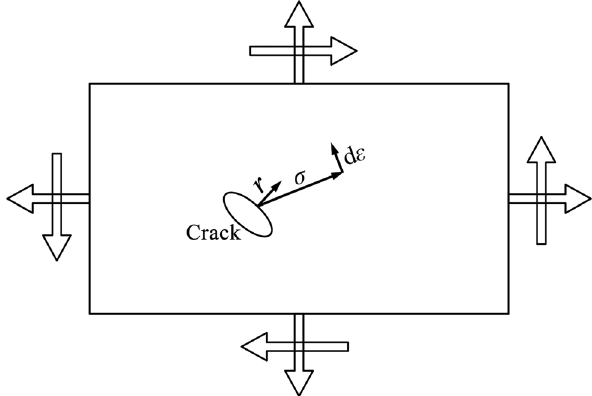
Figure 4: Schematic diagram of CED of rubber materials. ( r is the normal to the crack plane; σ is the vector of tensile stress; ε d is the vector of strain increments.